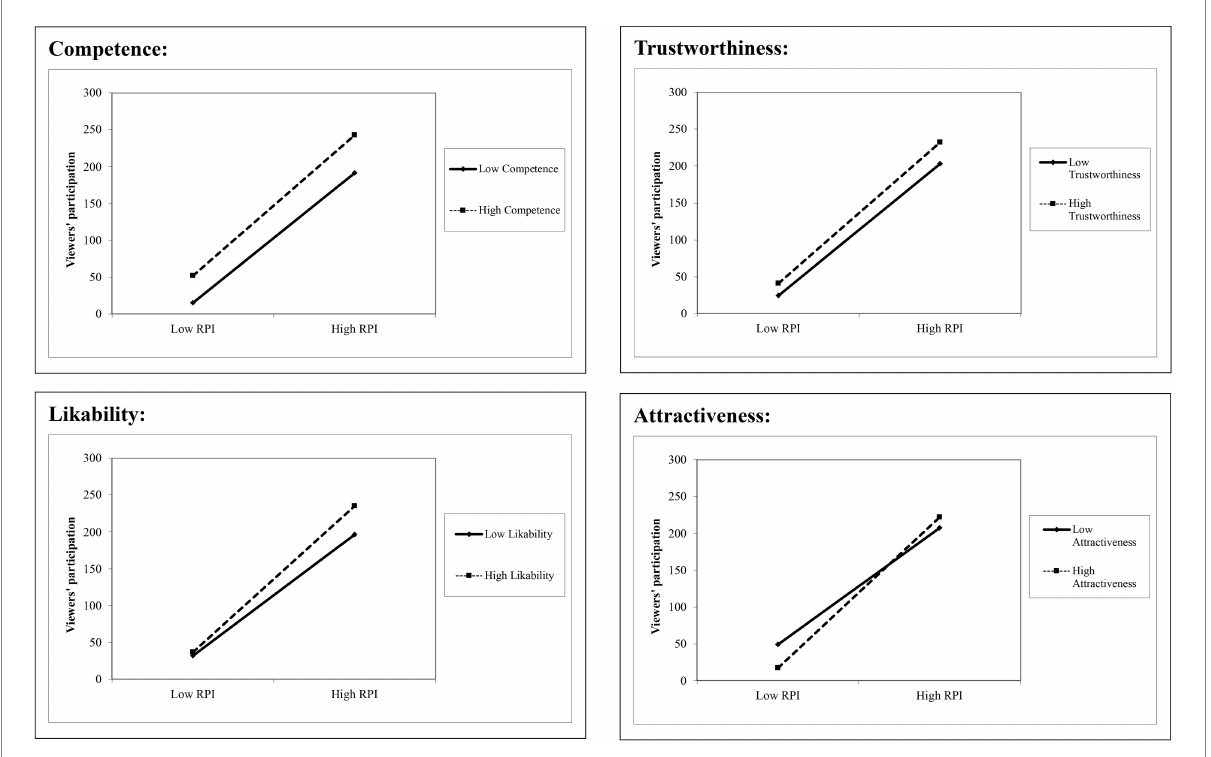
FIGURE 3 Relationship between RPI and viewer participation for high and low levels of each dimension of broadcaster